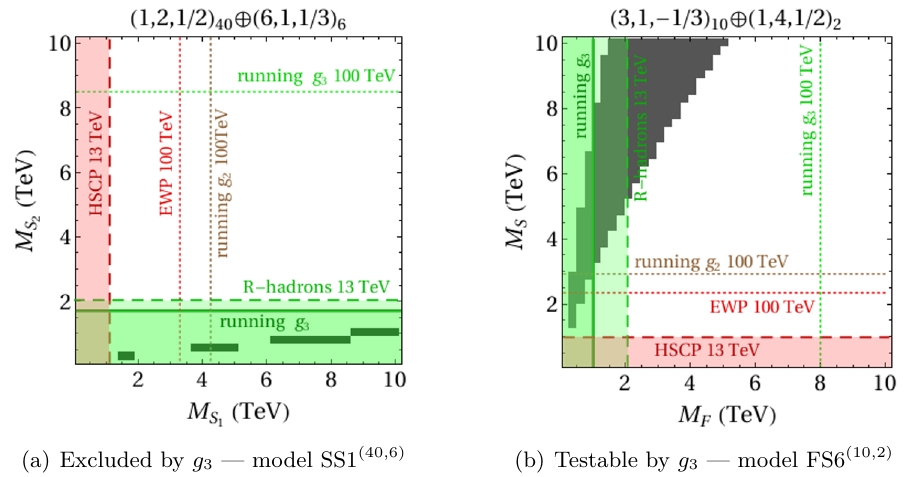
Figure 2 . Summary of experimental bounds on masses M 1 and M 2 in scenarios (a) SS1 (40 , 6) and (b) FS6 (10 , 2) . In dark gray the PGU region is indicated. The area below and left to the solid green line is excluded by the measurement of the running strong coupling constant by ATLAS [37]. The limits from the 13 TeV ATLAS R -hadrons search [41] are indicated as a dashed green line. The corresponding lepton-like HSCP search excludes the area left and below to a dashed red line. 100 TeV collider projections for the running g [40], running g [42], and for the EWP tests [43] are 3 2 depicted as green, brown and red dotted lines,